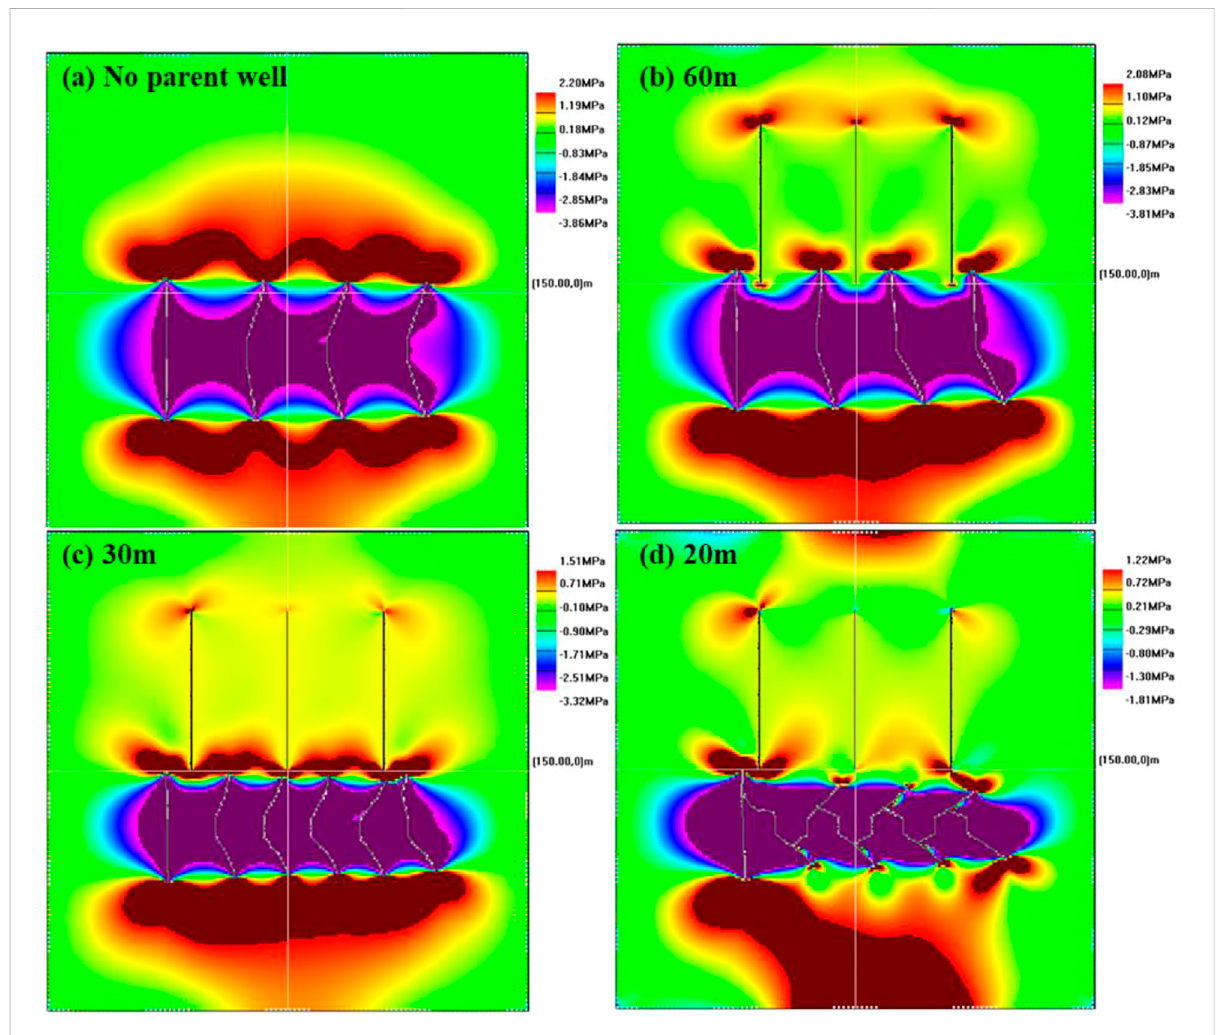
FIGURE 10 Normal stress fi eld distribution in X-axis direction around arti fi cial fractures under different fracture spacings.